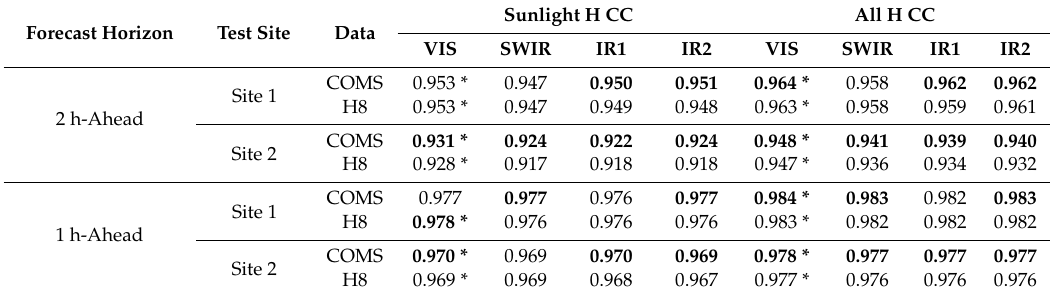
Table 7. Correlation coe ffi cient (CC) results from PV forecast for COMS and H8 datasets using the DNN model in “Sunlight H” and “All H” time frames. Forecast